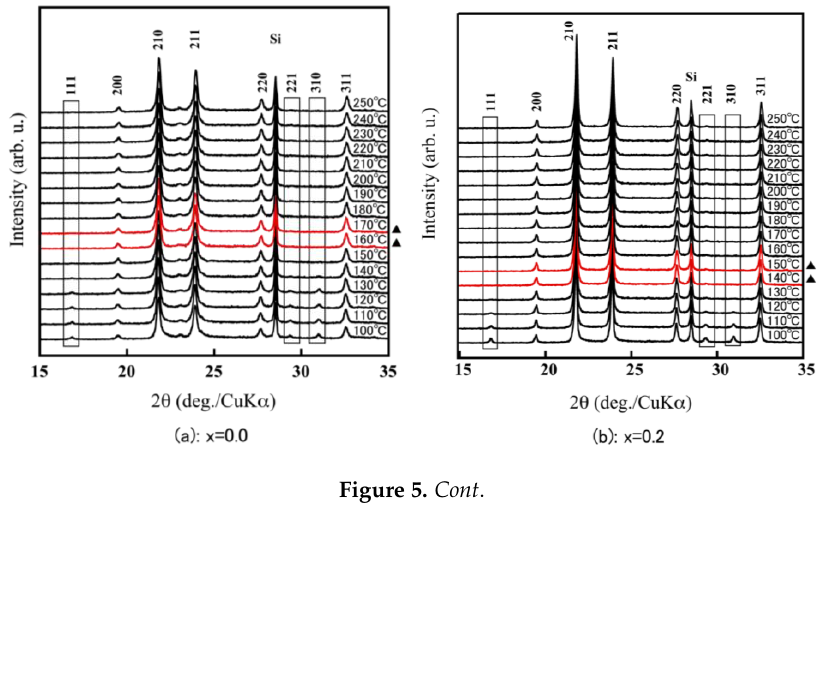
Figure 4. Scanning electron microscope (SEM) image of fractured surface of ZrW 2 O 8 sintered body.